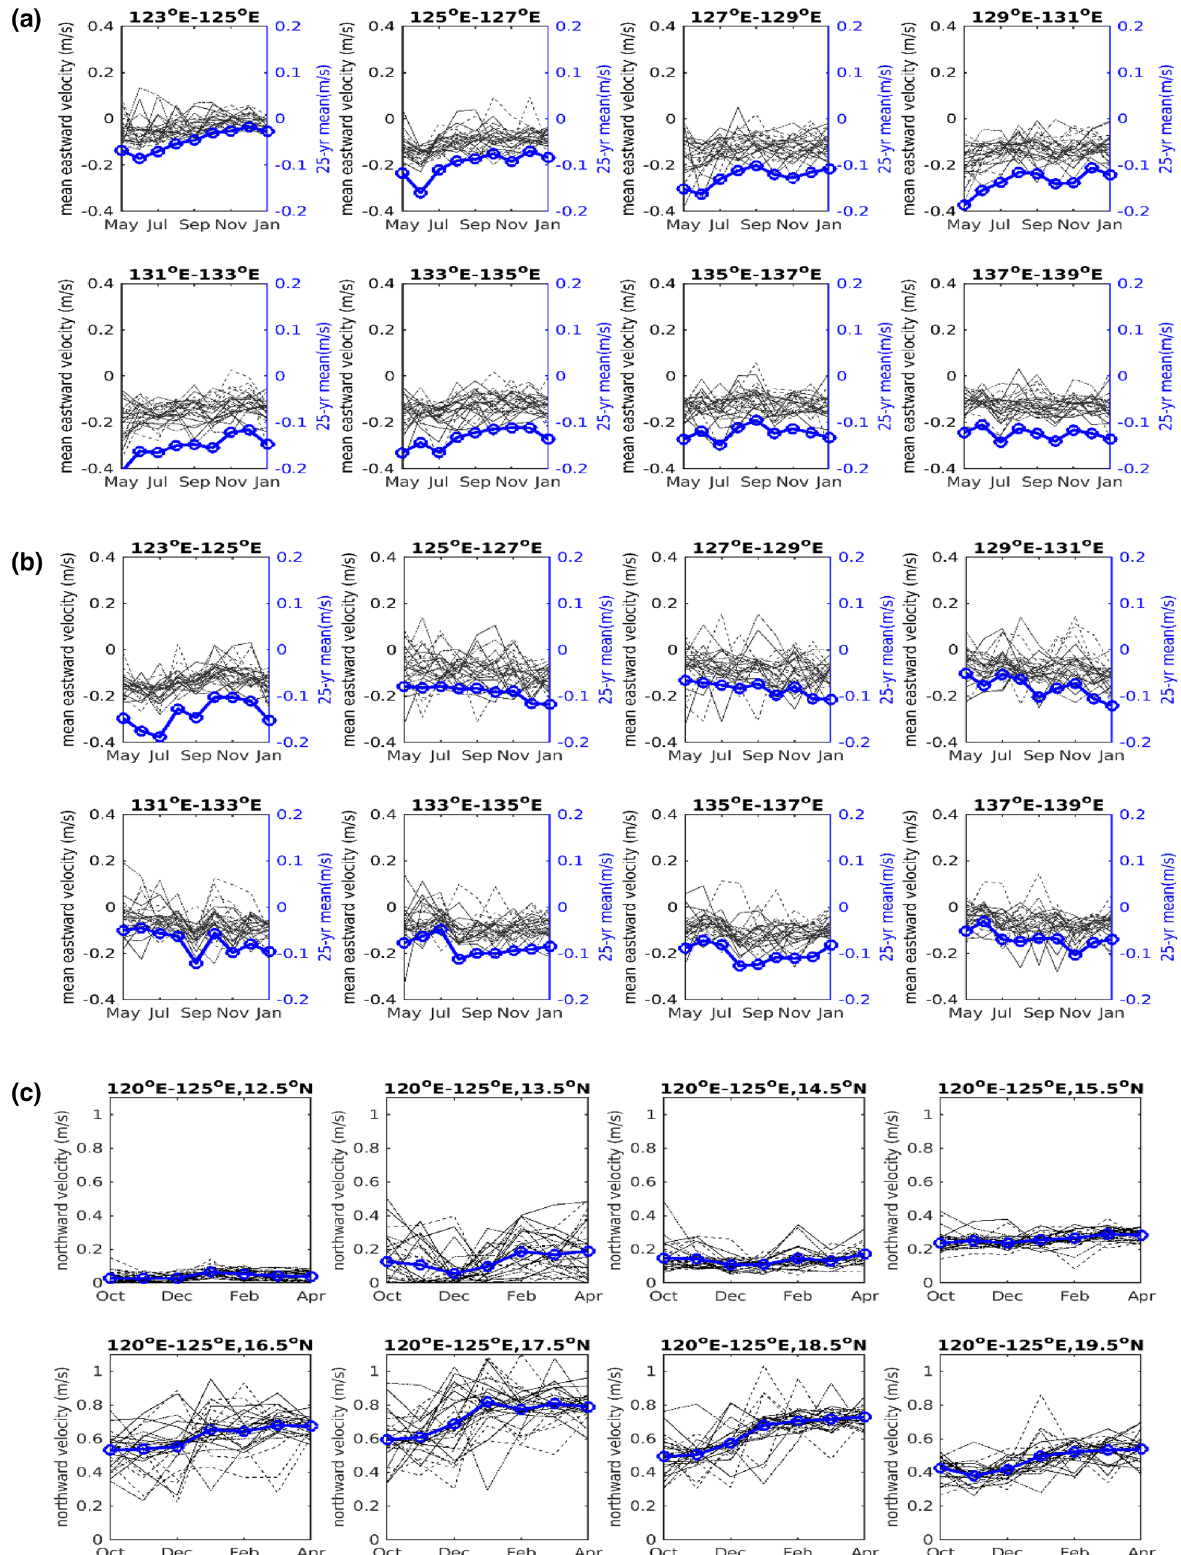
Figure 5. The main stream velocity (m/s, thin lines) of the NEC over 1994–2019 in the region of ( a ) 13–14° N, ( b ) 15–16° N, and ( c ) Kuroshio. The 25-year monthly mean (1994/5–2019/4) is superimposed (blue lines with circles). The enlarged y-axis at the right shows the trend